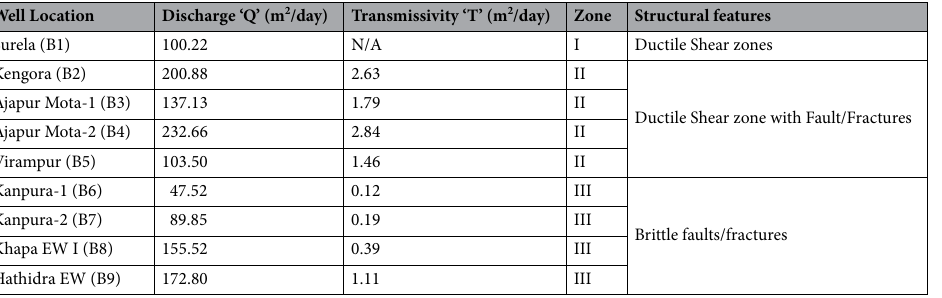
Table 2. Aquifer properties and borehole locations in different structural zones (Ambaji Basin, NW India).